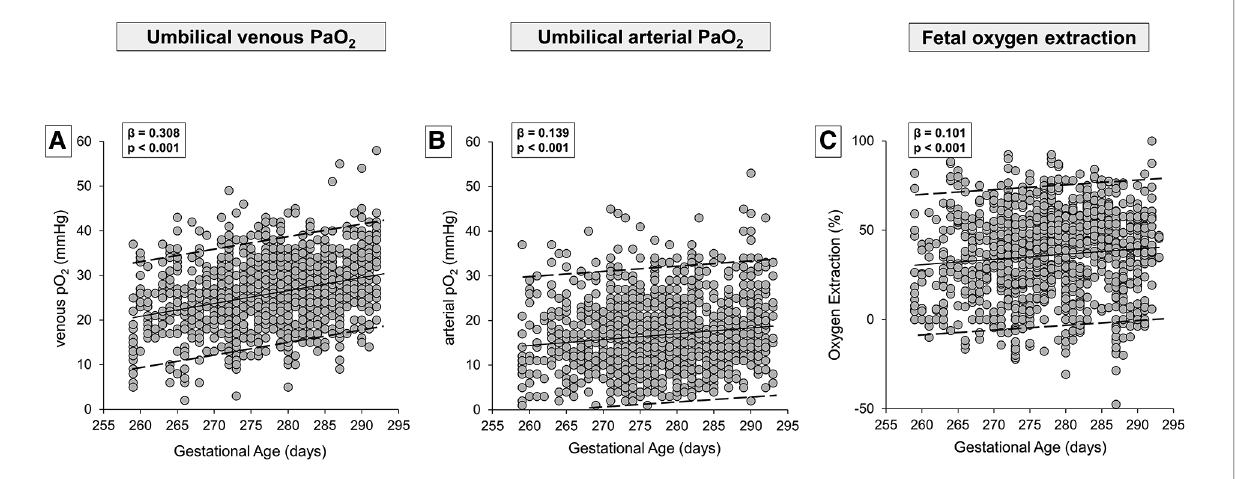
FIGURE 2 Scatter plots with regression lines and 95% prediction intervals representing umbilical-cord oxygenation status [venous PaO 2 , panel A ( n =1,233); arterial PaO 2 , panel B ( n =1,181); fetal oxygen extraction, panel C ( n =1,158)] of the whole study